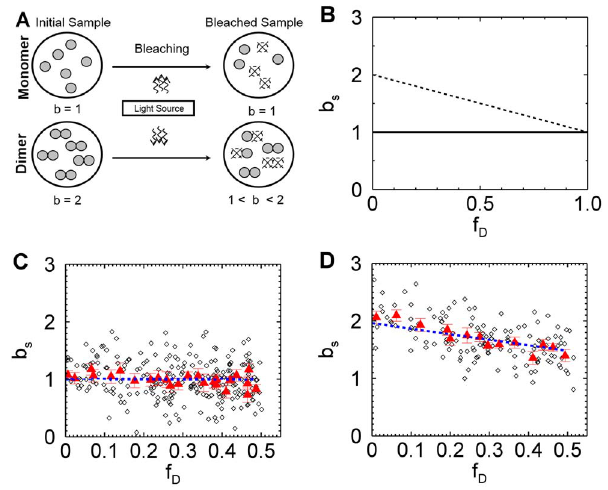
Figure 4. Segmented brightness analysis of monomers and dimers. (A) Illustration of photodepletion for monomers and dimers. Fluorescent molecules are depicted as filled circles and photobleached molecules are pictured as broken circles. The normalized brightness of monomers ( b =1) remains unchanged by photodepletion, In contrast, photobleaching of a dimeric sample with initial brightness of 2 leads to a reduction of brightness as explained in the text. (B) Theoretical brightness based on segmentation analysis of a monomeric (solid line) and dimeric (dashed line) sample as a function of photodepletion. (C) Brightness of EGFP from a yeast cell by segmentation analysis versus photodepletion fraction. Brightness values (diamonds) for a data segment size of 1.6 s. Ten consecutive brightness values are averaged (red triangles) to better visualize the trend of the data. The dashed blue line represents a fit of the brightness values to Eq. 6 with a fitted value of b 0 ~ 1 : 00 + 0 : 03 . (D) Brightness of EGFP 2 from a yeast cell by segmentation analysis versus photodepletion fraction. Symbols are described under (C). The blue dashed line represents a fit of the brightness values to Eq. 6 with a fitted value of b 0 ~ 1 : 96 + 0 : 03